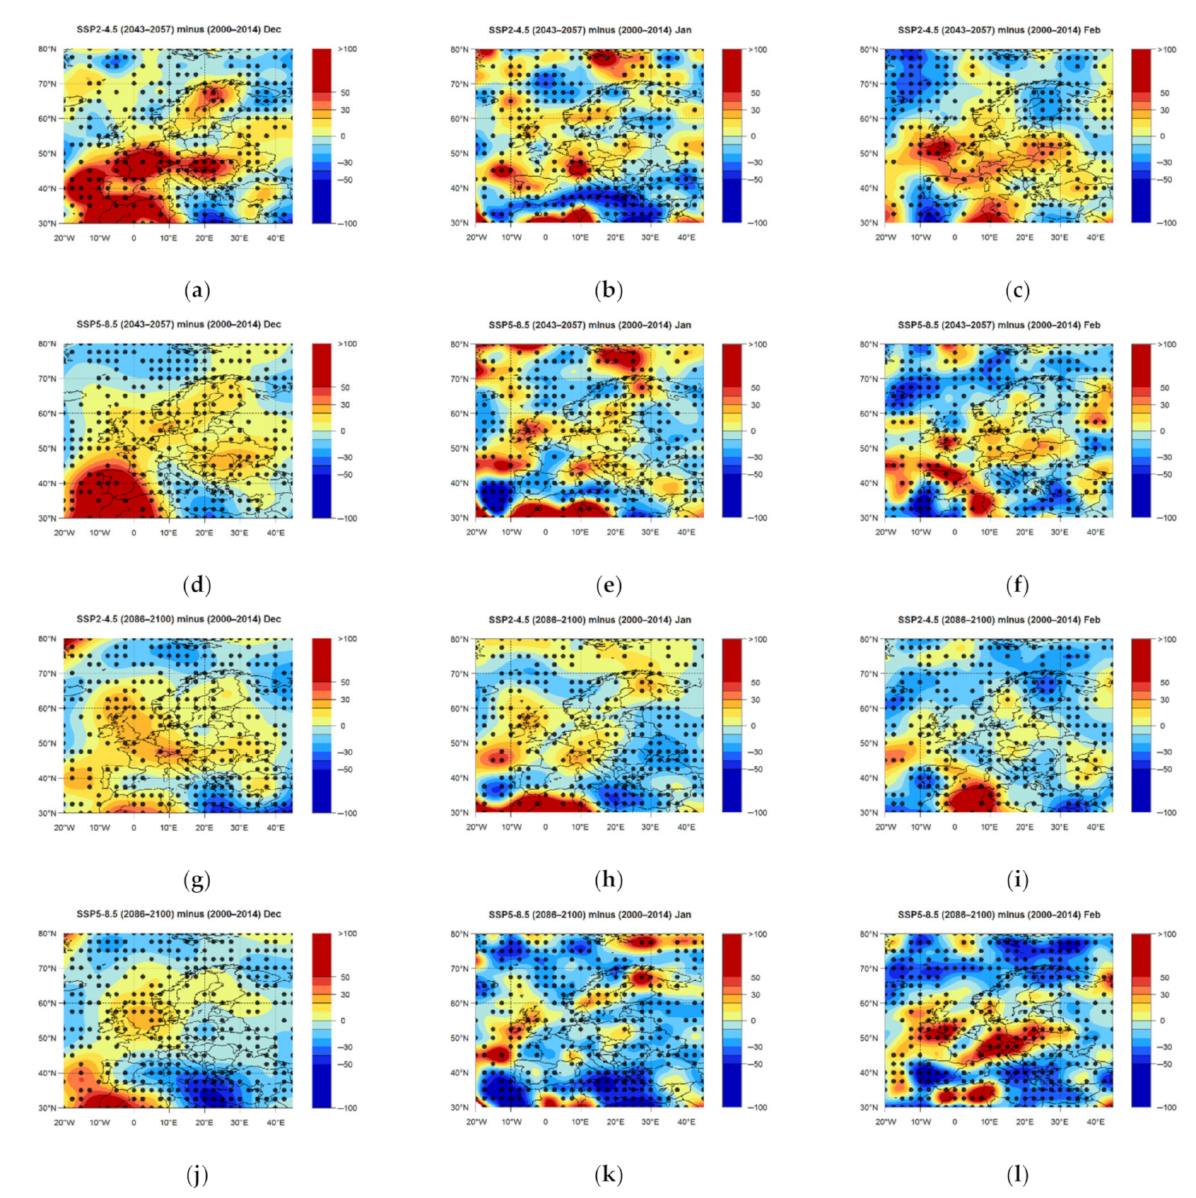
Figure A2. Anomalies (%) of the frequency of cyclones relative to the recent historical period (2000 to 2014) at the beginning of the century in December (left column), January (central column), and February (right column): ( a – f ) at the middle of the 21st century; ( g – l ) at the end of the 21st century; ( a – c , g – i ) under the SSP2-4.5 scenario; ( d – f , j – l ) under the SSP5-8.5 scenario. Stippling indicates where 70% of the models agree on the sign of